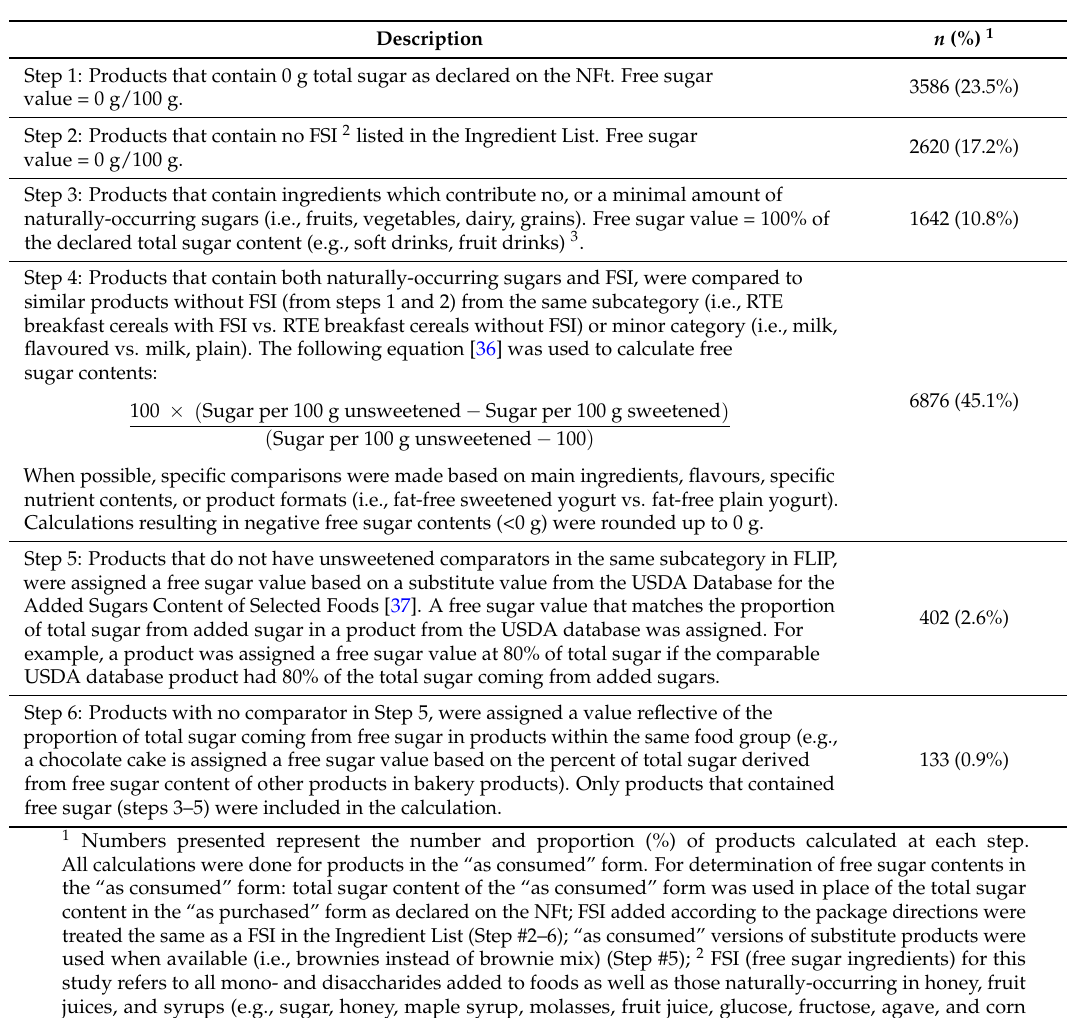
Table 1. Step-by-step method for calculating free sugar content of foods and beverages in the University of Toronto’s Food Label Information Program (FLIP) database 2013 and number of foods at each step (total n =